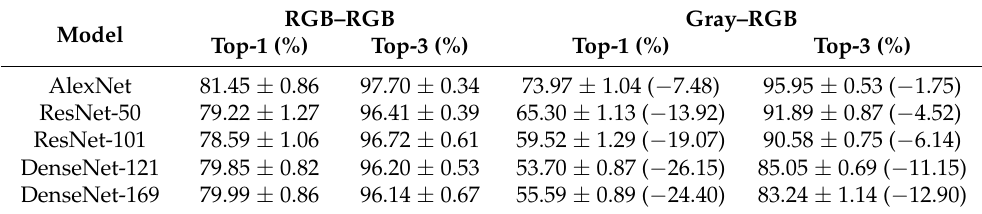
Table 2. Detection accuracy of scratch-trained convolutional neural networks on FF_Smoke dataset.